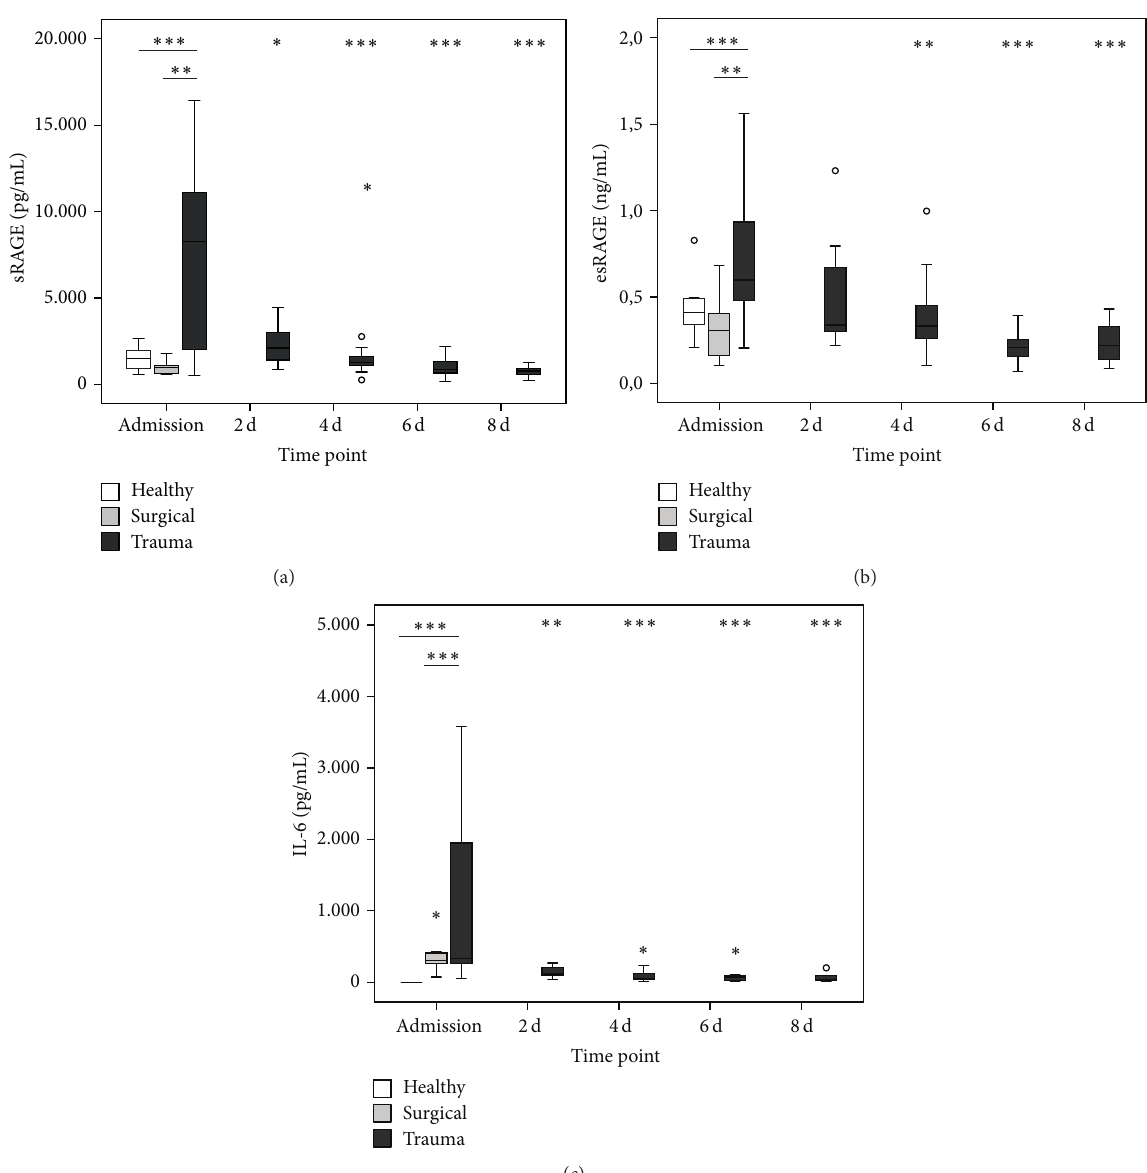
Figure 1: Plasma concentrations of RAGE isoforms and IL-6 after trauma. sRAGE (a), esRAGE (b), and IL-6 (c) levels at admission ( 𝑛 = 16 /10/10 for trauma/surgical/healthy) and 2 d ( 𝑛 = 16 ), 4d ( 𝑛 = 15 ), 6d ( 𝑛 = 11 ), and 8 d after trauma ( 𝑛 = 11 ). ∗ 𝑃 < 0.05 , ∗∗ 𝑃 < 0.01 , and ∗∗∗ 𝑃 < 0.001 compared to trauma at admission (Mann-Whitney 𝑈